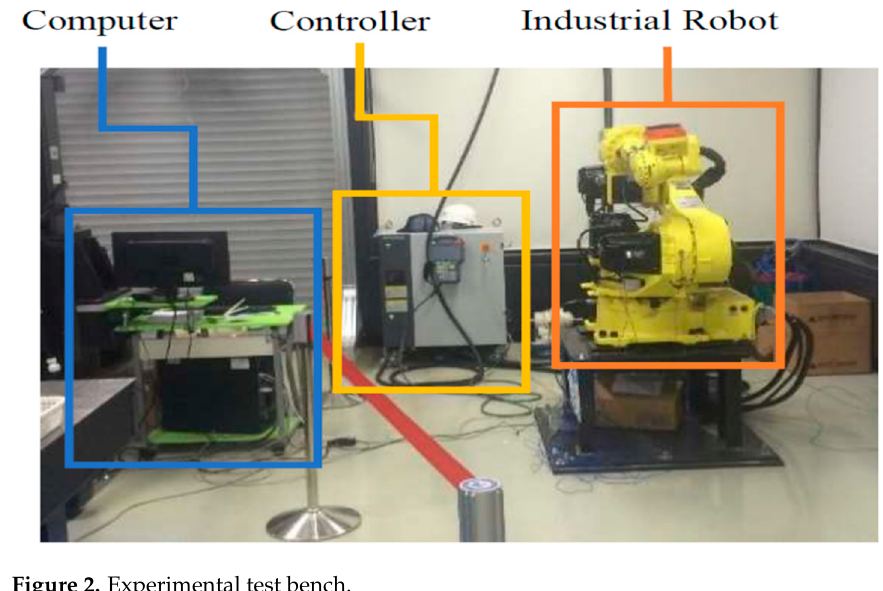
Figure 2. Experimental test bench.